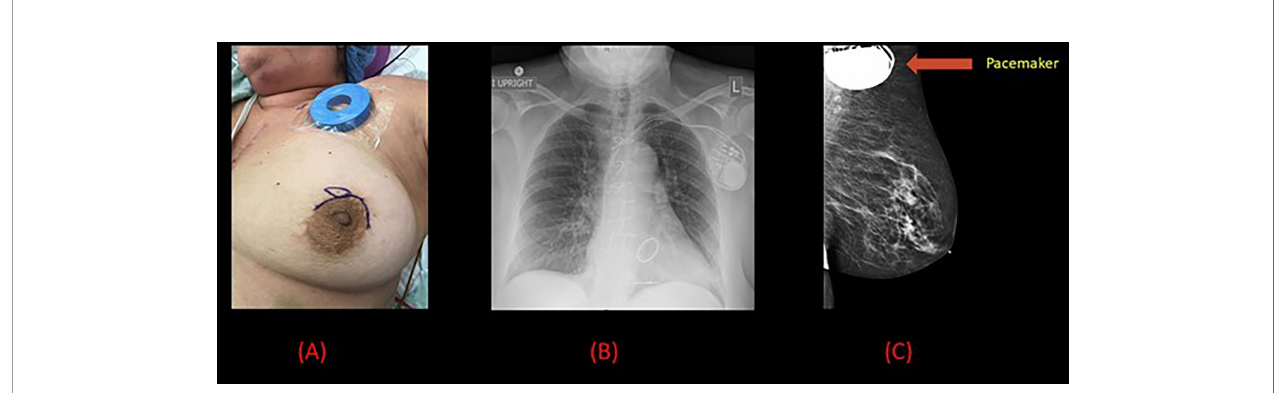
FIGURE 3 | Pre-operative and radiological images for patient 2. (A) Pre-operative image of the left breast with a magnet placed on the pacemaker and surgical marking indicating the tumor site. (B) Chest x-ray demonstrating left sided pacemaker with leads projecting over the right atrium and right ventricle. (C) Mammogram demonstrating a 7 mm spiculated mass in the left breast along with